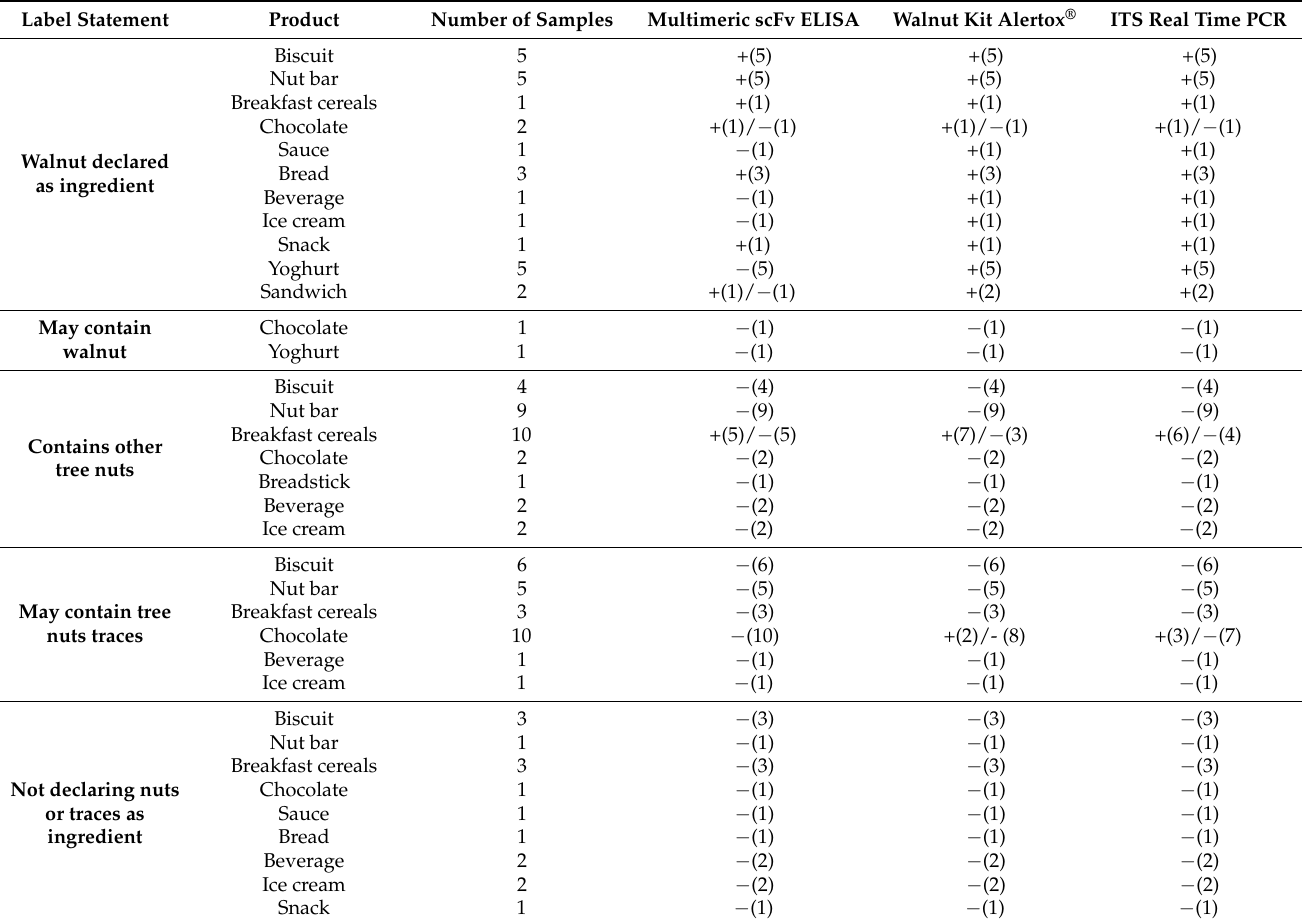
Table 4. Determination of the presence of walnut in commercially processed food products using multimeric scFv ELISA, Alertox ® Walnut ELISA kit, and real time